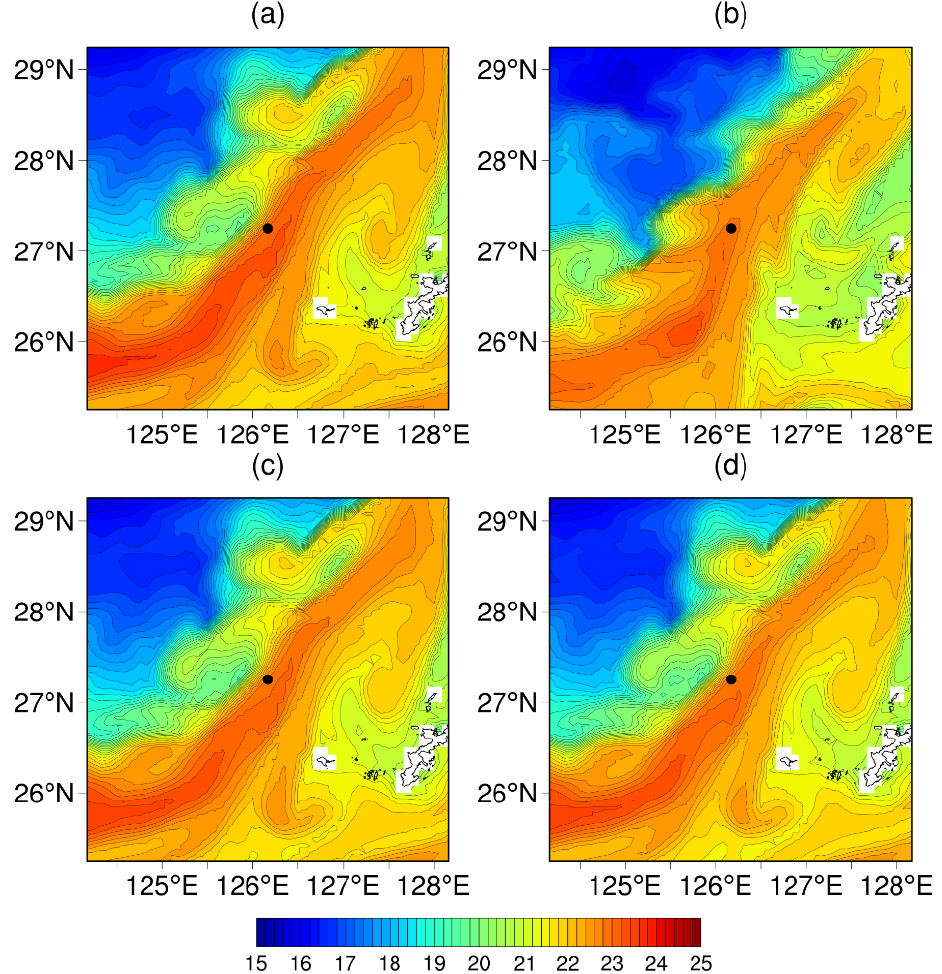
Figure 4. Results of the group A experiment (the Kuroshio Current in the East China Sea) on 1 January 2015, the black dot in the figure is the observation point; ( a ) background field of the single-point observation experiment; ( b ) target field of the single-point observation experiment; ( c ) analysis field of the single-point observation experiment (EnOI); ( d ) analysis field of the single-point observation experiment (EnOS).